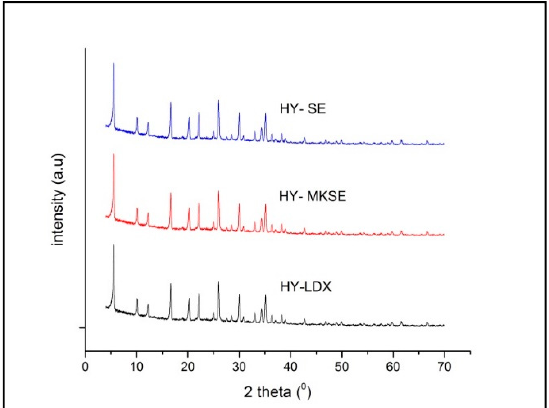
Figure 13. XRD data of HY- LDX (bottom), HY-MKSE (middle) and HY-SE (top).